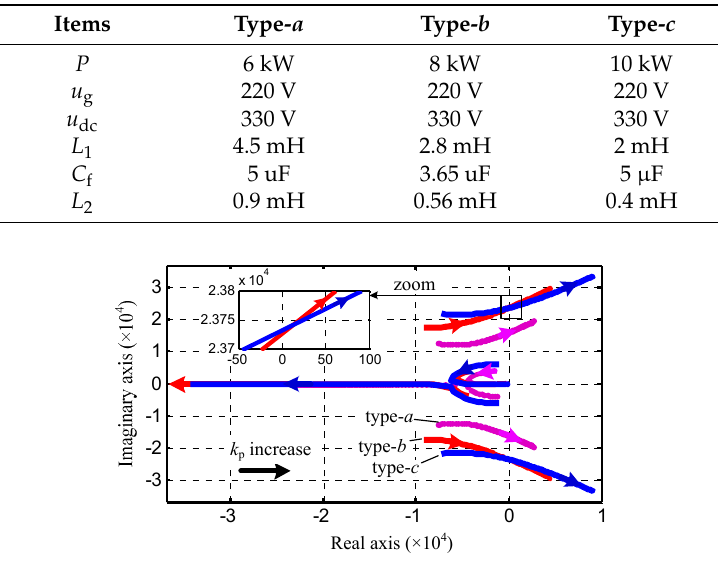
Table 2. System construction.